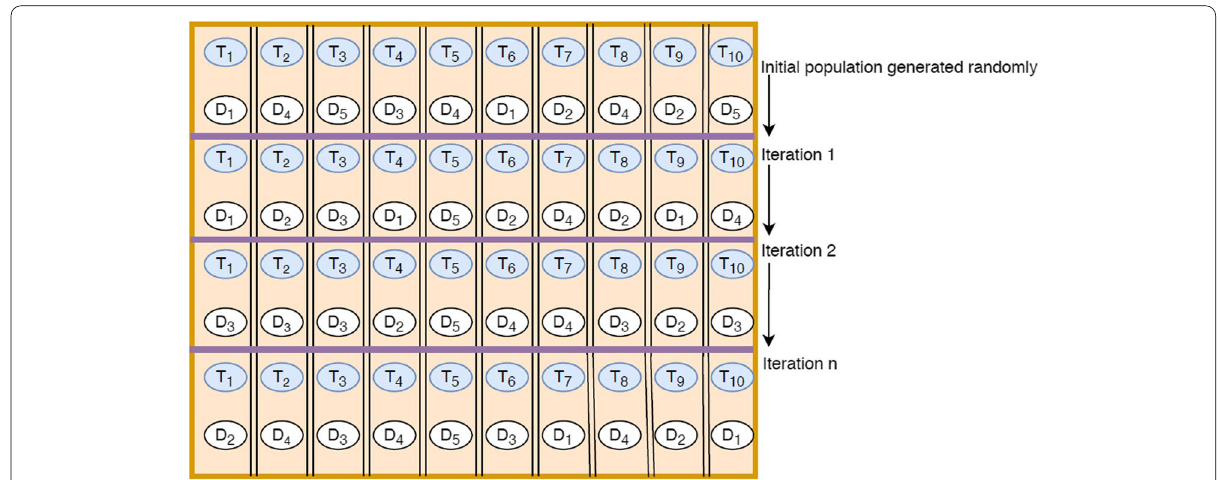
Fig. 2 Tasks – Resources Initialization Process (T represents Task while D represents device or cloud VM)